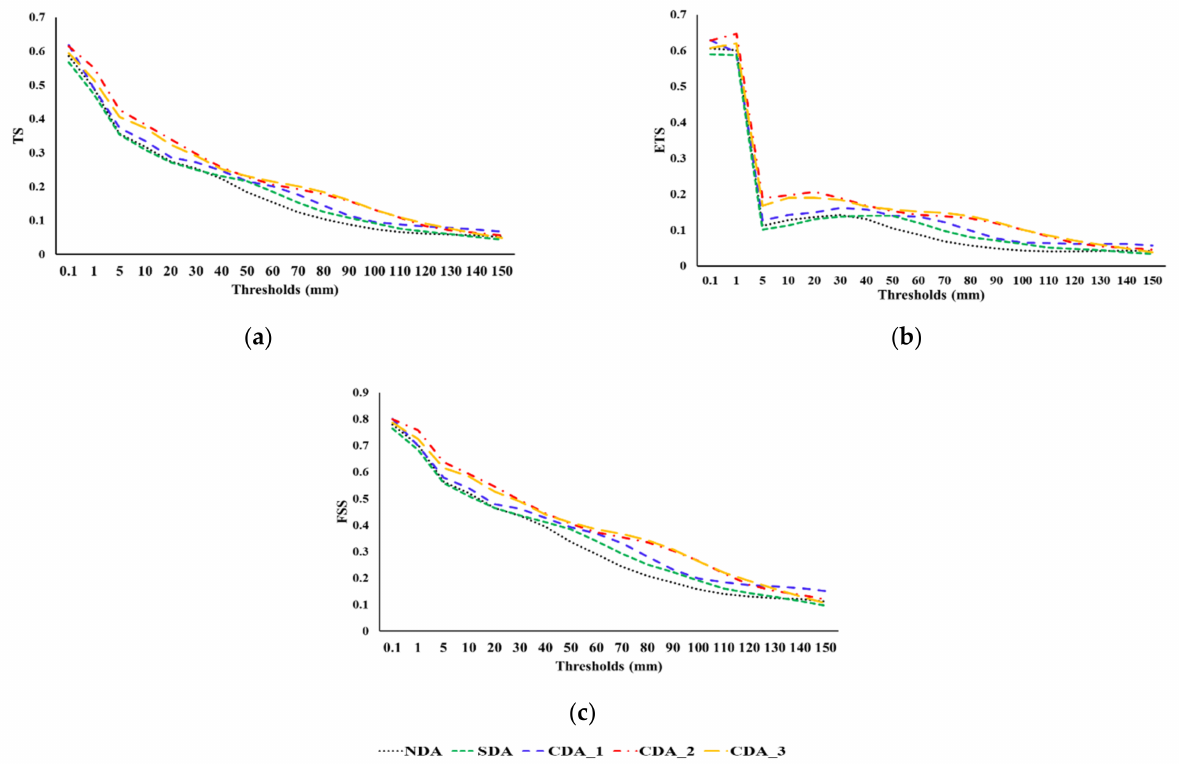
Figure 14. Similar to Figure 13, but for 24-h accumulated rainfall forecast scores as a function of threshold. ( a ) threat score (TS), ( b ) equitable threat score (ETS), and ( c ) fraction skill score